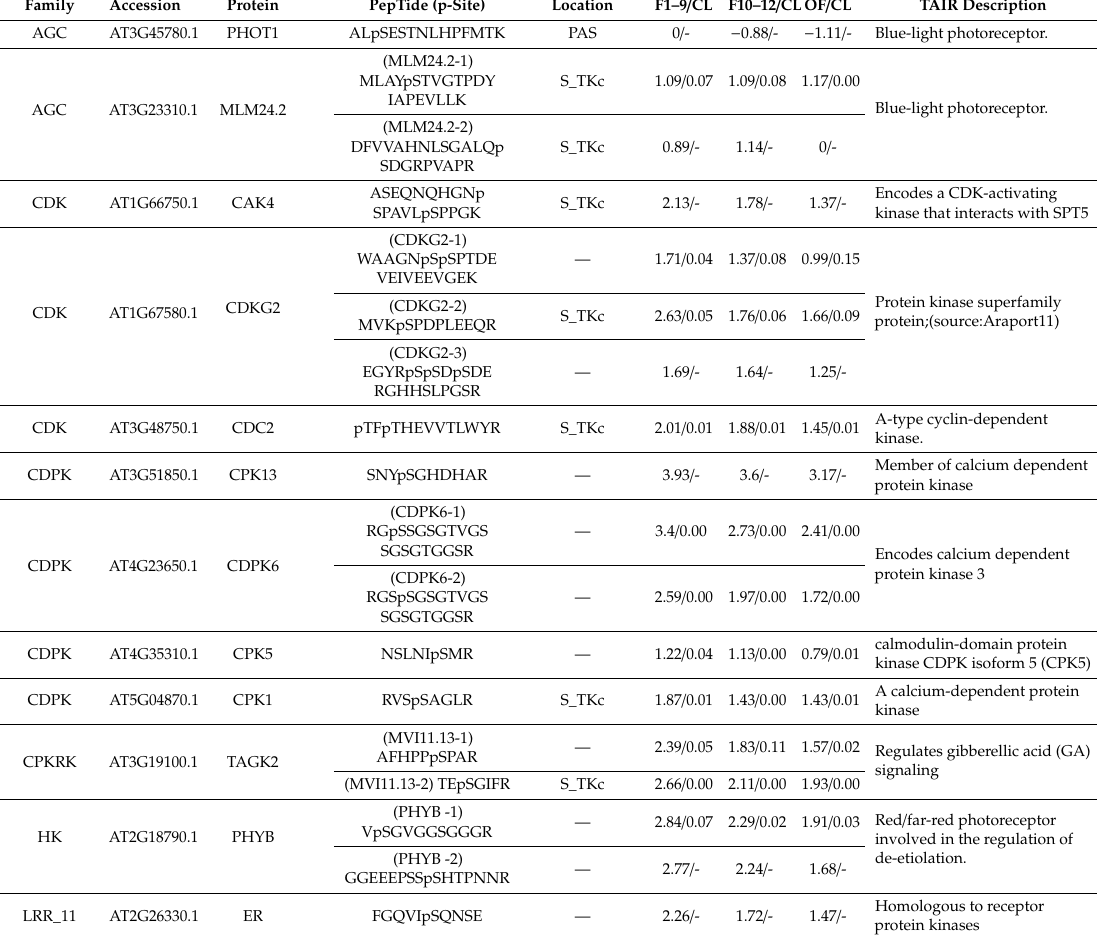
Table 3. Comparison of di ff erent phosphor-peptides belonging to the kinases and phosphatases in di ff erent floral stages and the cauline